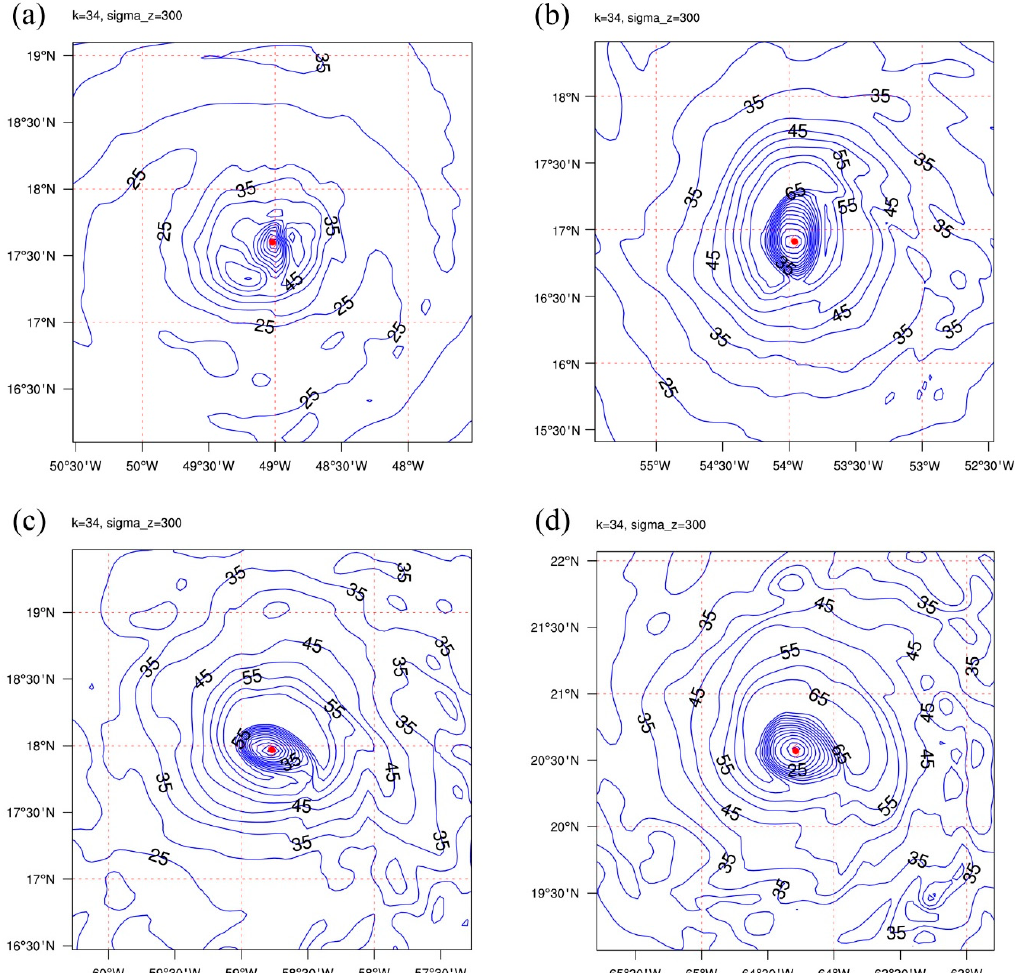
Figure 16. As in Figure 14, except from ( a ) the initial conditions from the CIMSS hourly AMV FCDI analysis at 1800 UTC 3 September as indicated in Figure S1d, and then COAMPS-TC forecasts at ( b ) tau + 24 h, ( c ) tau + 48 h, and ( d ) tau + 72 h.